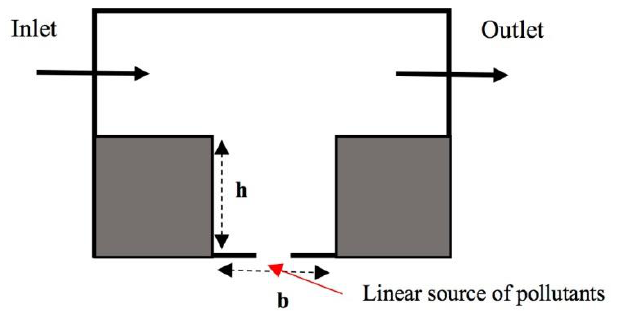
Fig. 1. The computational domain with the